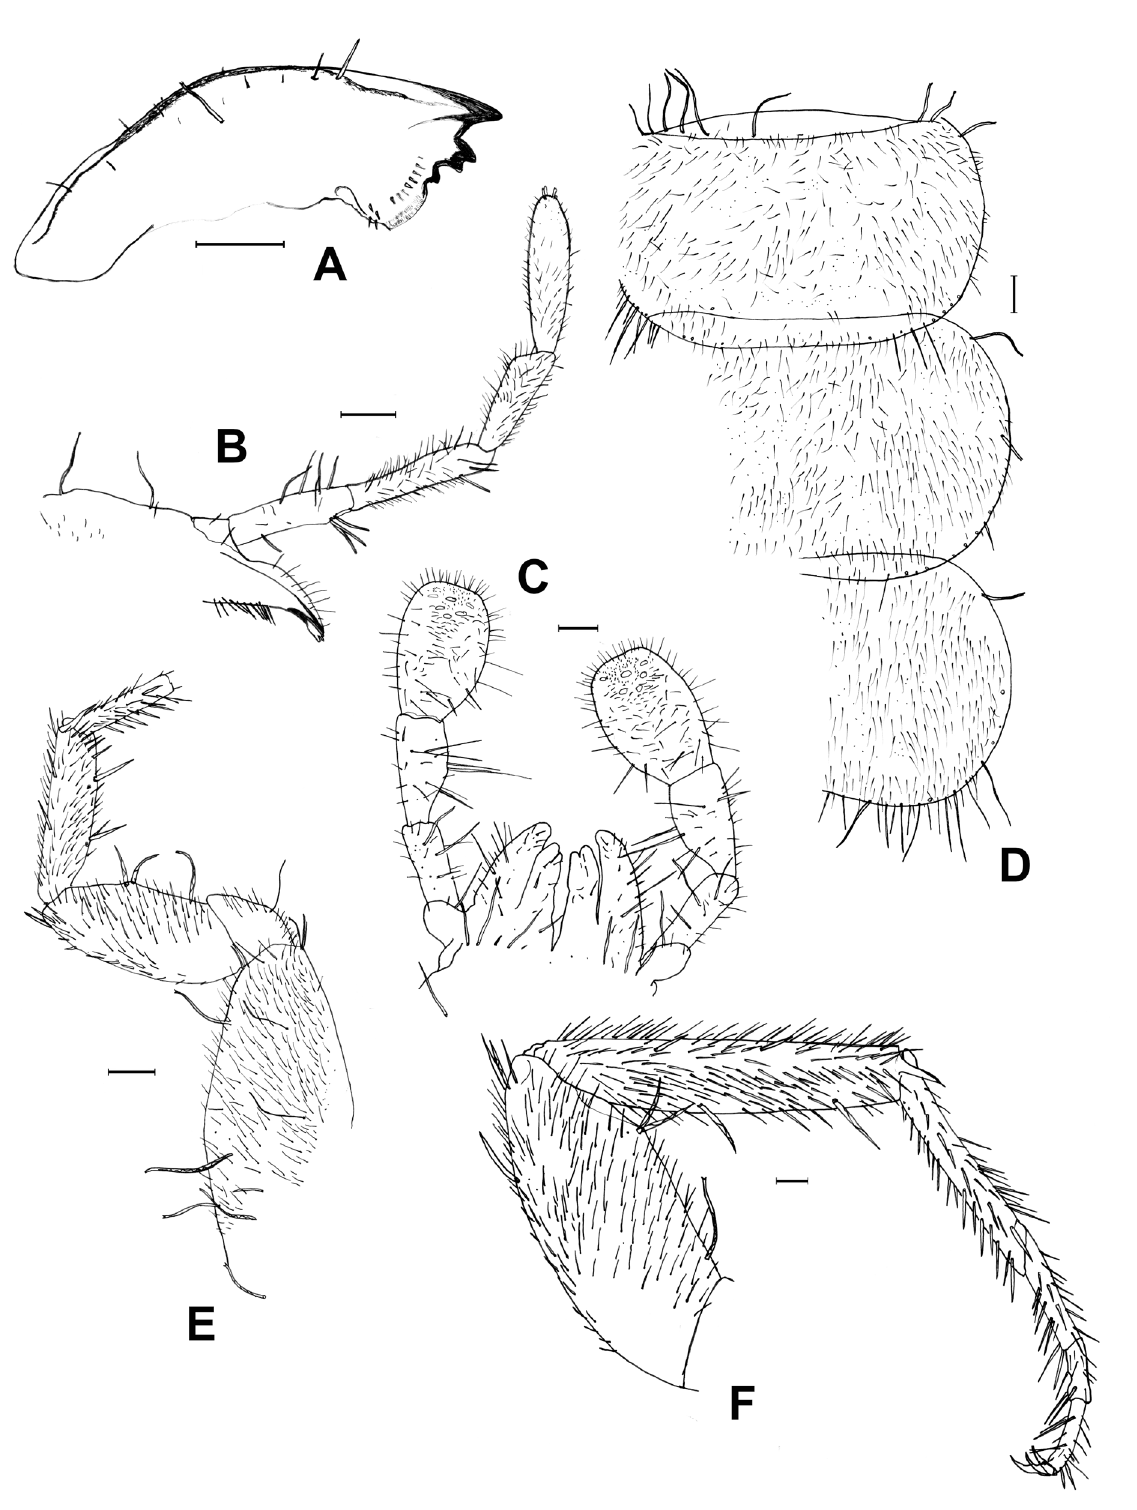
Fig. 3. Coletinia dalmatica Molero-Baltanás, Fišer, Bach de Roca & Gaju-Ricart sp. nov. Holotype, ♂ (MNCN_Ent 283558). A . Mandible. B . Maxilla and maxillary palp. C . Labial palps and anterior part of the labium. D . Thoracic nota. E . First leg, excluding apical tarsomeres. F . Femur, tibia, tarsal articles and praetarsus of the third leg. Scale bars: A, C, F = 0.1 mm; B, D–E = 0.2